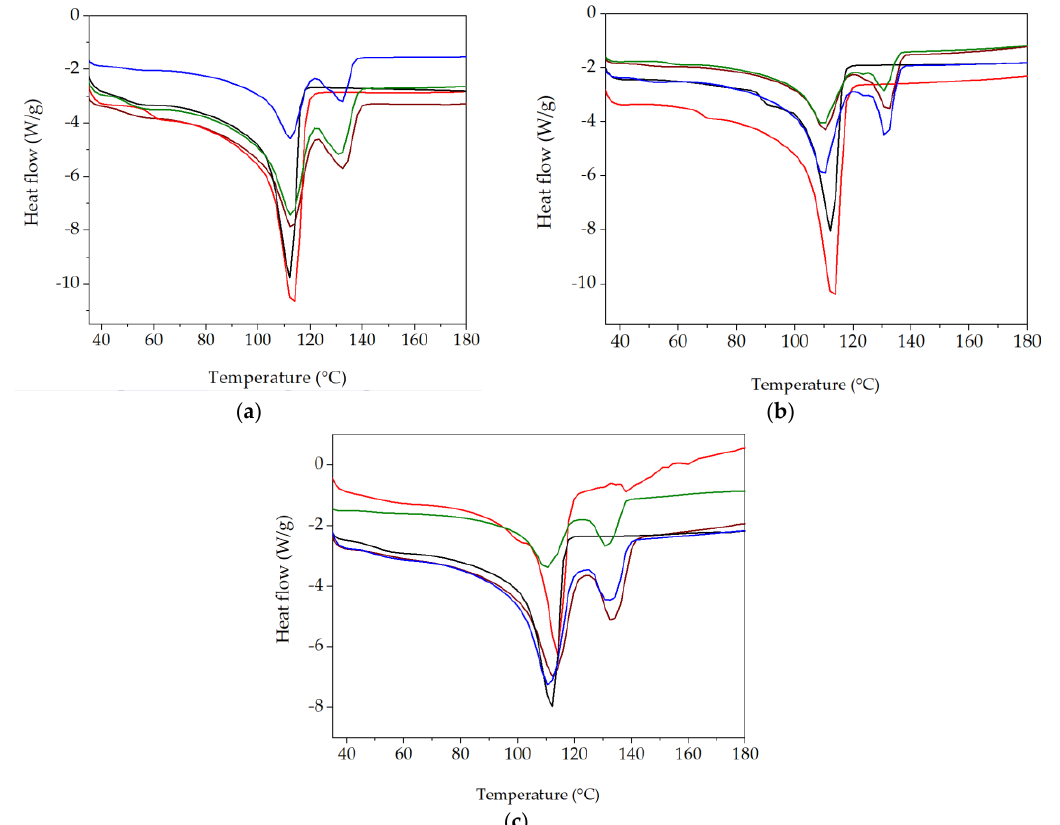
Figure 8. DSC thermograms for various LDPE-based composites (first heating scan) at 0 kGy ( a ), 50 kGy ( b ), and 100 kGy ( c ) (exo down). Sample compositions: brown) LDPE/UHMWPE; ( --red ) LDPE/HAp; ( --black ) LDPE/HAp/RM; ( --green ) LDPE/UHMWPE/HAp; ( --blue ) LDPE/UHMWPE/HAp/RM.